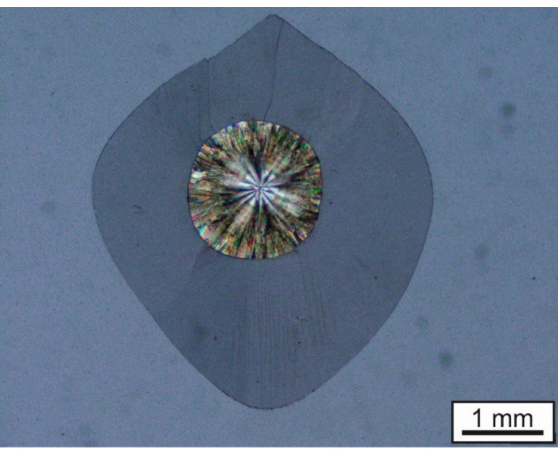
Figure 2. A rounded crystal of calcite, CaCO 3 , containing a radial spherulite at its core due to too strong a